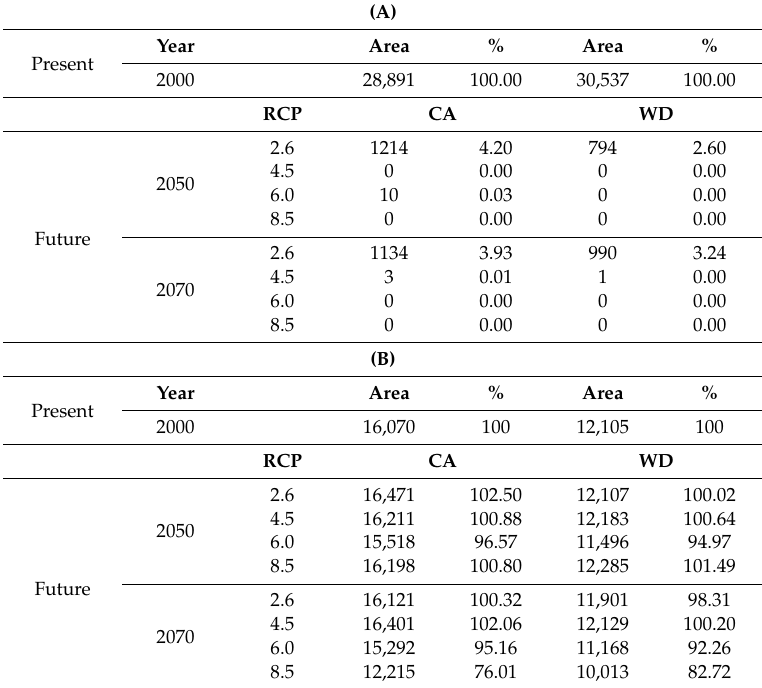
Figure 6. Future probability of occurrence of E. grandis obtained with the ensemble global model circulation CCSM4, in the scenarios RCP 2.6, 4.5, 6.0, and 8.5, for the years 2050 and 2070. Table 4. Future projection for the total area (ha) and prediction (%) of Eucalyptus dunni ( A ) and E. grandis ( B ) for di ff erent scenarios (RCP 2.6, 4.5, 6.0, and 8.5), applying Global Circulation Model